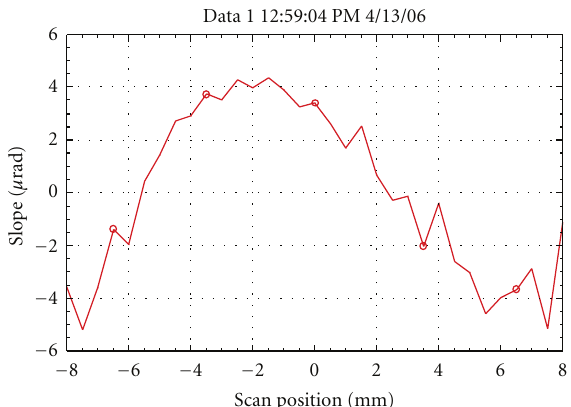
Figure 8: Systematic slope error caused by the BLM is ∼ 2 μ rad rms for the LTP